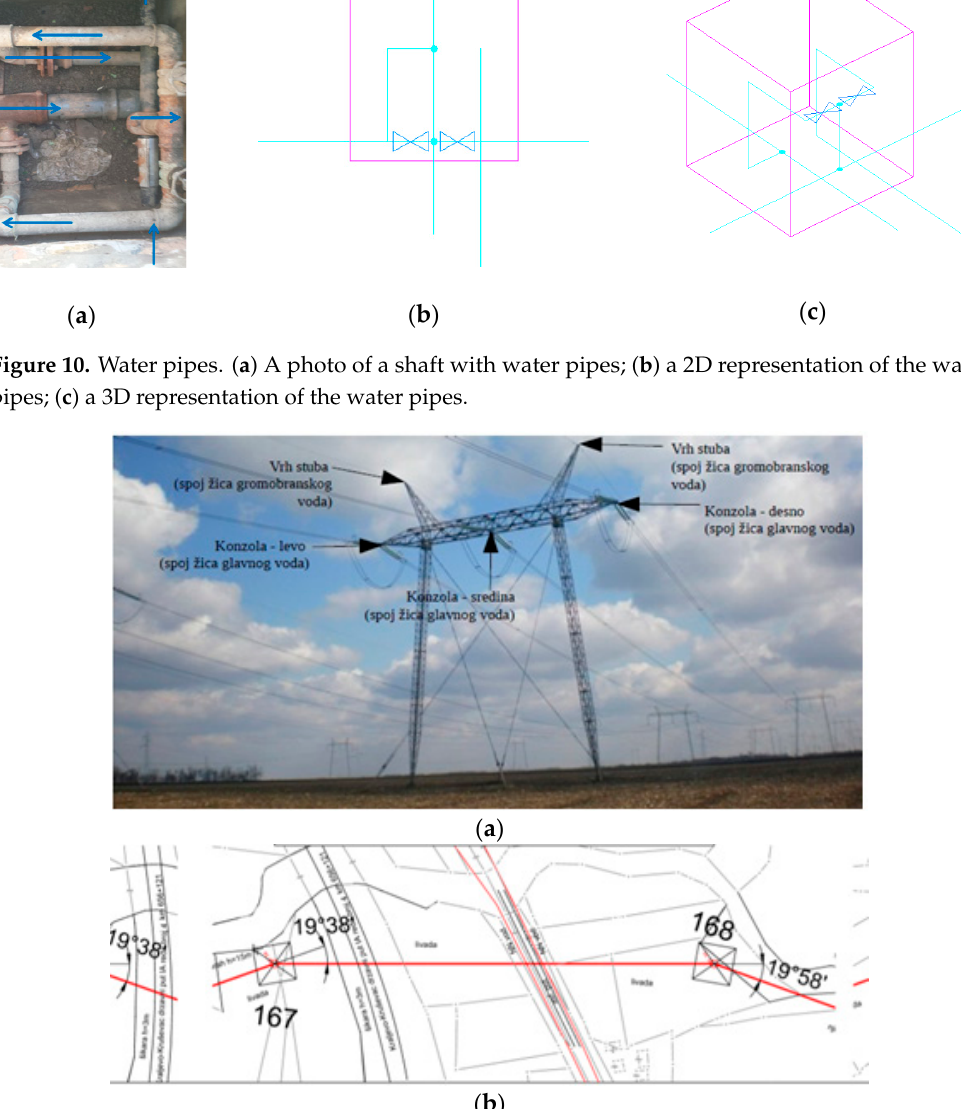
Figure 11. Powerlines. ( a ) A photo of a pole with powerlines; ( b ) a 2D representation of the powerlines.